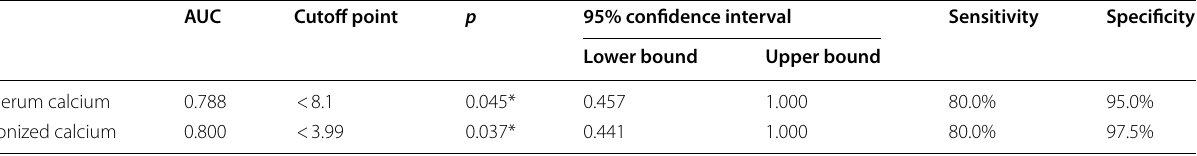
p < 0.05 is *(significant) AUC area under curve